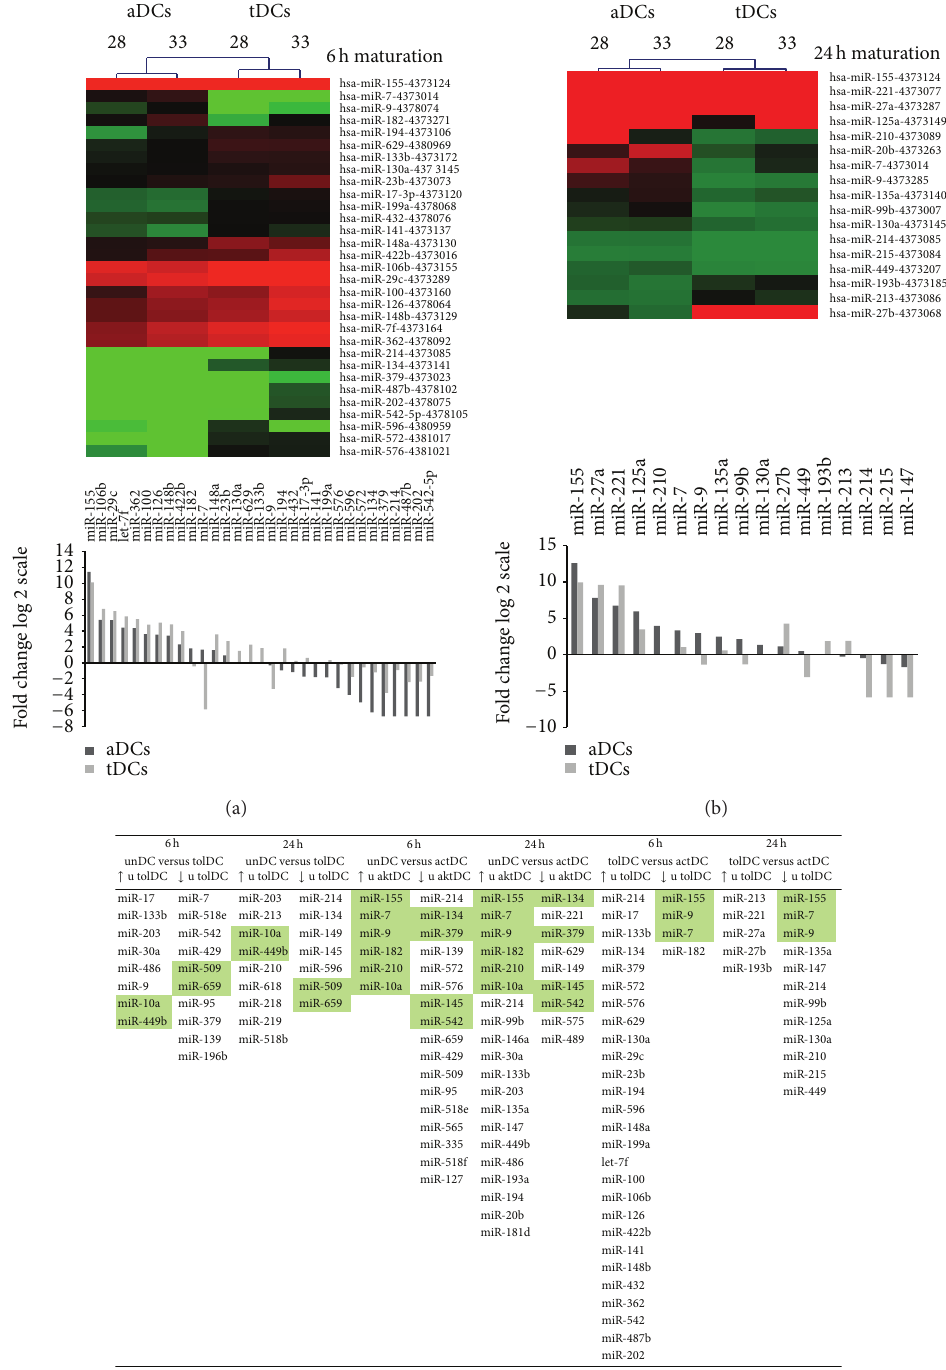
Figure 4: Comparison of miRNA profiles in activated versus tolerogenic DCs after 6h and 24 h of maturation. Immature iDCs were cultured with GM-CSF (800 UI/mL) and IL-4 (500 UI/mL) for 6 days. On day 6, the media were replaced for iDCs containing LPS/IFN- 𝛾 (aDCs) or containing IL-10/TGF- 𝛽 (tDCs) for next 6h or 24h maturation. The q-PCR based TLDA miRNA expression analysis was provided in all DCs samples. Gene expression values for miRNAs were normalized using RNU6B as an endogenous control. The relative expression levels of target miRNAs were determined by the equation 2 −Δ Ct , in which Δ Ct were calculated as follows: Δ Ct = CtmiR-of-interest − Ct RNU6B. The observed changes in miRNA expression with fold change higher than twofold were analyzed. The results are visualized through heat maps and dendrograms. Green-red colour scale display in the heat maps increasing miRNA in measured samples. (a) miRNA expression in 6h aDCs versus 6 h tDCs. (b) miRNA expression in 24h aDCs versus 24 h tDCs. (c) Table summarizing upregulated and downregulated miRNAs in aDCs and tDCs upon 6 and 24 h of maturation and